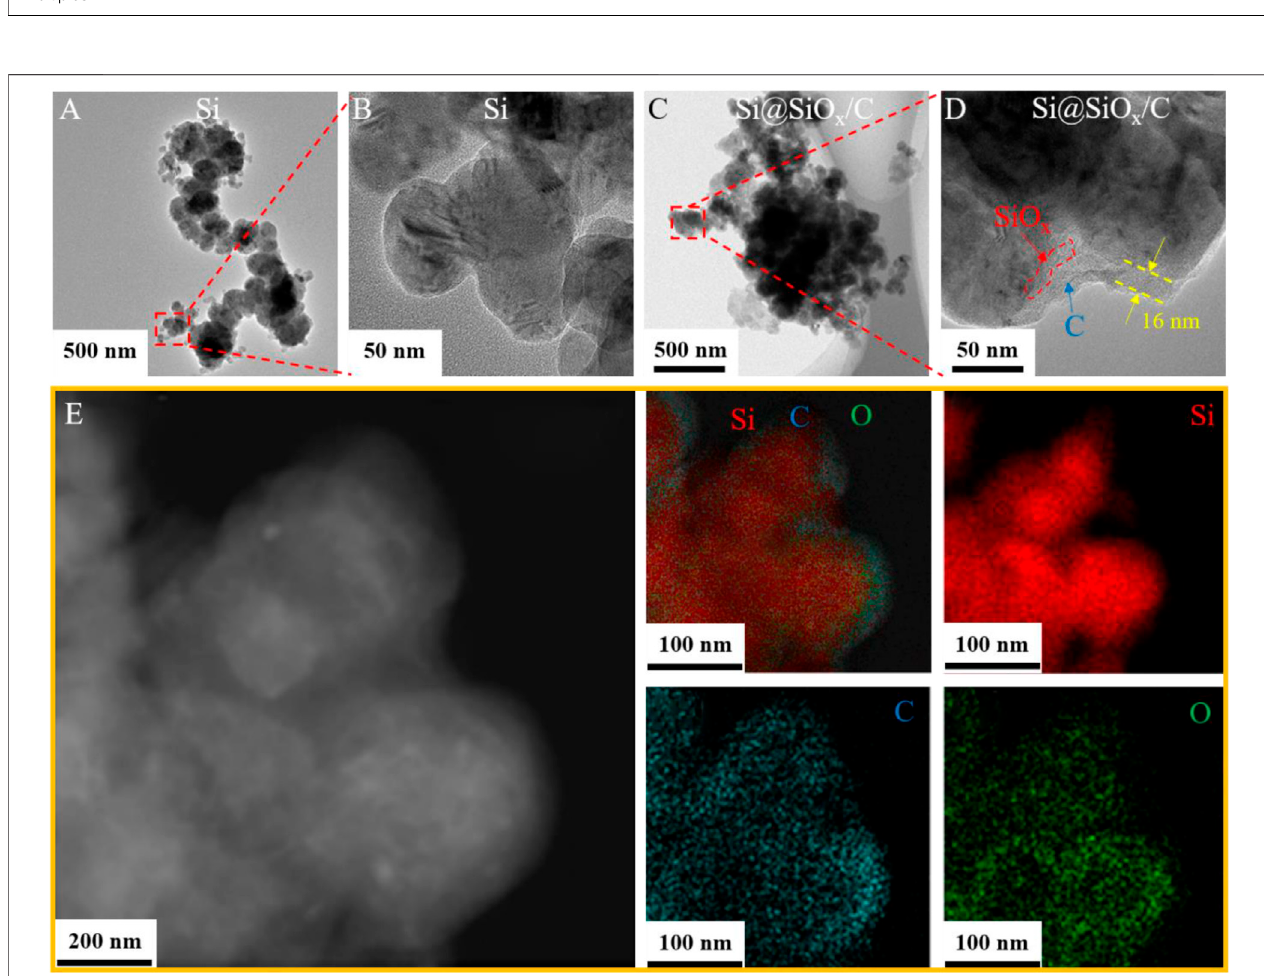
Frontiers in Chemistry |